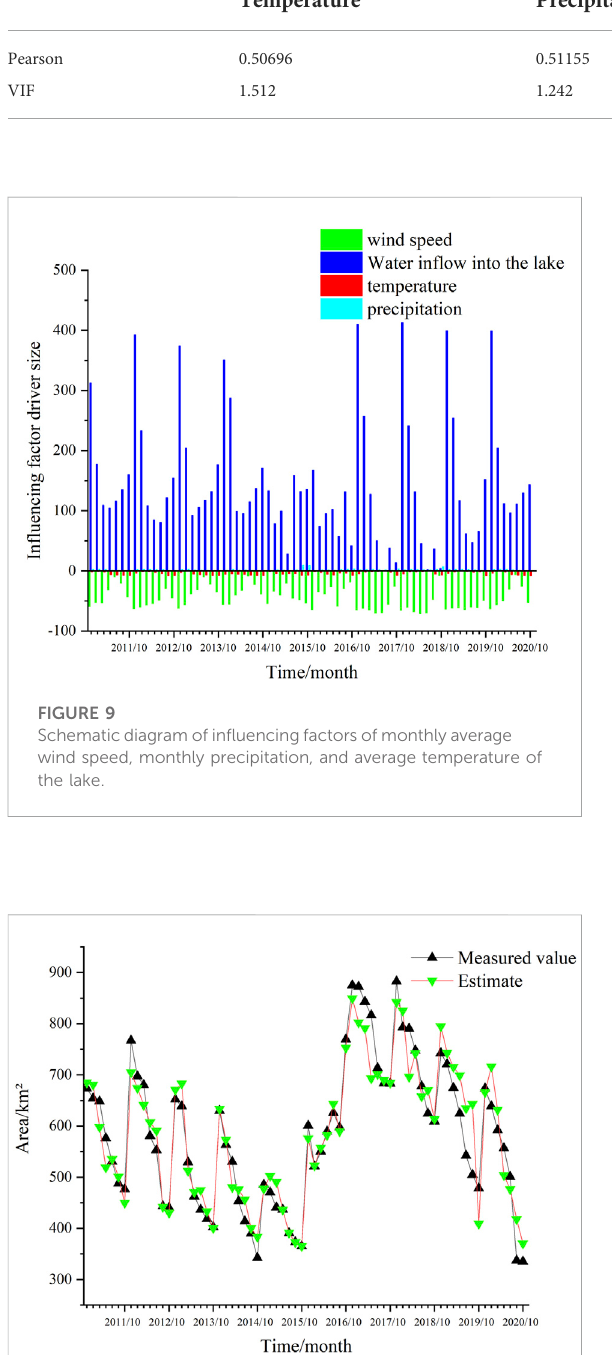
FIGURE 10 Monthly lake surface area calculated based on the GTWR